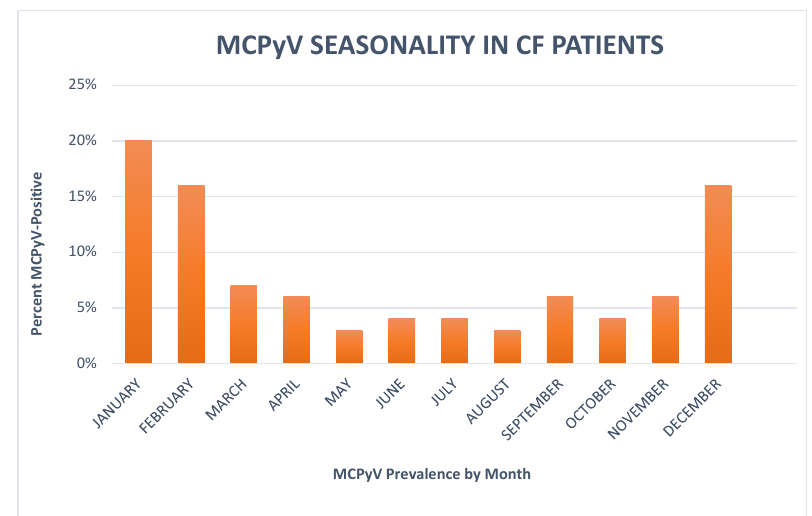
Figure 1. Bars represent the percentages (%) of Merkel cell polyomavirus (MCPyV)-positive samples. The percent of MCPyV-positive cases was observed predominantly in December, January, and February, with highest detection in January (20% of the month’s samples). CF = cystic fibrosis. Finally, in order to study the properties of MCPyV strains circulating in a CF cohort, a MCPyV VP1 alignment was carried out comparing 10 CF representative oropharyngeal aspirate samples and reference strains EU375803 and EU375804 [1]. Results revealed a 99% homology with the deposited sequences of MCPyV in GenBank (Figure 2). Furthermore, a phylogenetic analysis including MCPyV reference sequences EU375803 and EU375804, the same 10 oropharyngeal aspirate samples, and representative BKPyV, JCPyV, KIPyV, and WUPyV sequences (NCBI) showed that all CF isolated strains fell into the same cluster (Figure